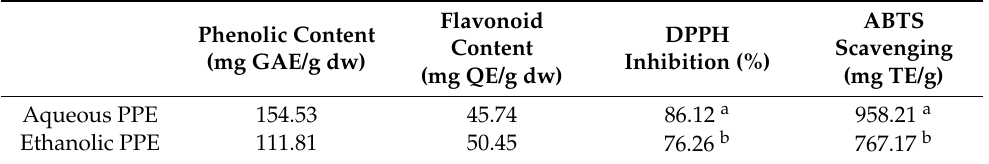
Table 1. Phenolic compounds content and antioxidant potential of pomegranate peel extracts (PPE). Flavonoid Phenolic Content Content (mg GAE/g dw) Aqueous PPE Ethanolic